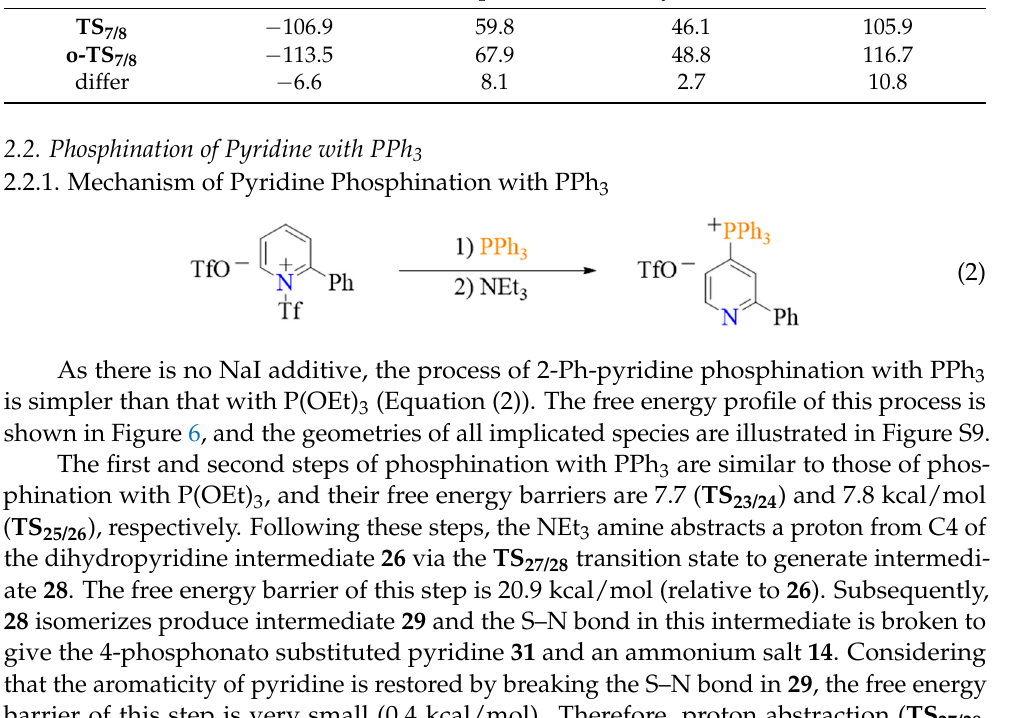
Table 2. Interaction and strain energies of the TS 7/8 and o-TS 7/8 transition states (unit kcal/mol). E strain E inter Phosphonate Pyridine Sum TS